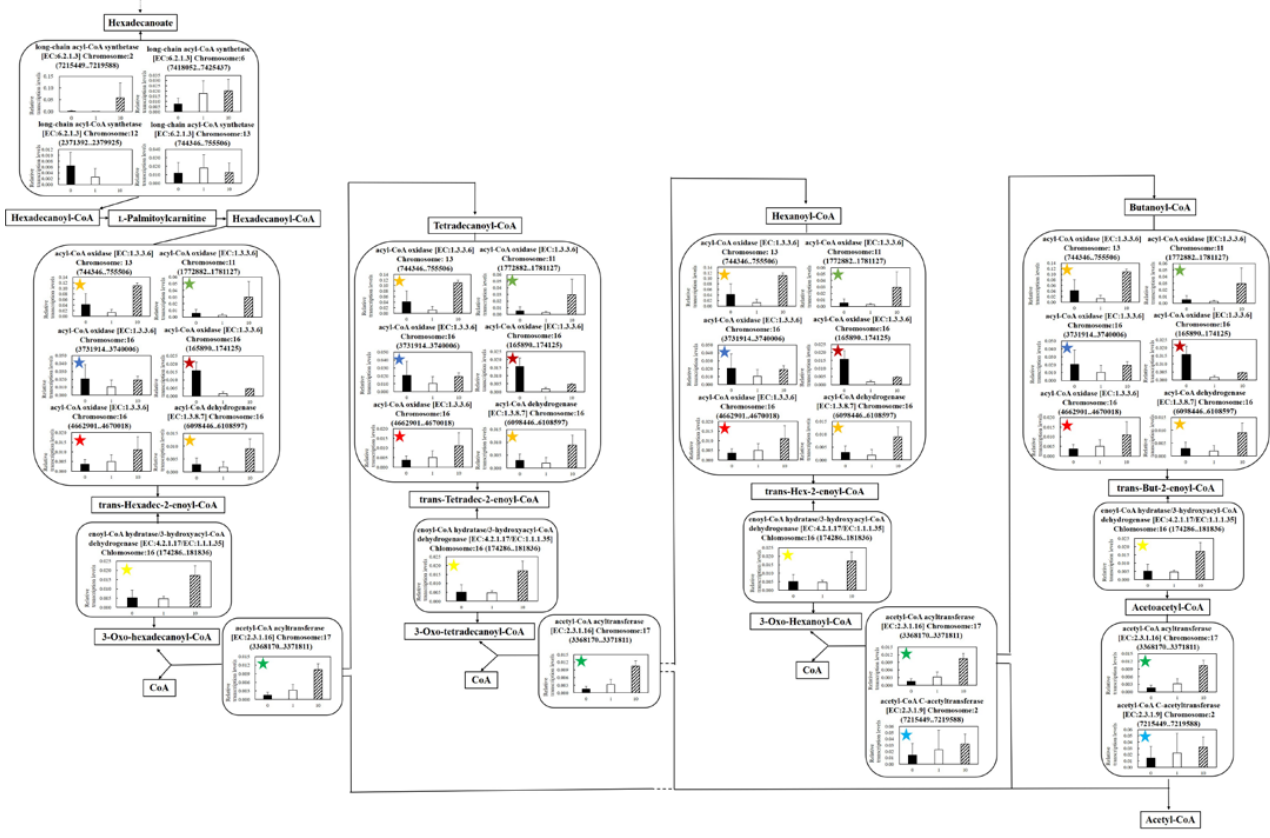
Figure 5. Relative quantification of mRNA of C. reinhardtii at 0 min, 1 min and 10 min of UV-C irradiation: ( a ) glycolysis; ( b ) TCA cycle; ( c ) lipid-synthetic pathway; ( d ) lipid-degrading pathway. Data were shown as relative mRNA transcription levels normalized by the level of ATPS as a housekeeping gene. Relative transcription levels at 0 min, 1 min and 10 min of UV-C irradiation time were shown in black, white and striped, respectively. Error bars indicate SD of 3~6-time replicates experiments. Metabolites, glycerol 3-phosphate: G3P; lysophosphatidic acid: Lyso-PtdOH. Enzymes, hypo-ligases: Hypo1; hypo-transferases: Hypo2; phosphoglucoisomerase: PGI; fructose-1,6-bisphosphatase: FBP; phosphofructokinase: PFK; fructose-bisphosphate aldolase: FBA; glyceraldehyde 3-phosphate dehydrogenase: GAPDH; glyceraldehyde-3-phosphate dehydrogenase: GAPN; phosphoglycerate kinase: PGK; phosphoglycerate mutase: PGM; enolase: ENO; pyruvate carboxylase: PC; citrate synthase: CIS; ATP citrate (pro-S)-lyase: ACL. The same-colored stars in ( b ) and ( d ) indicated the same genes.